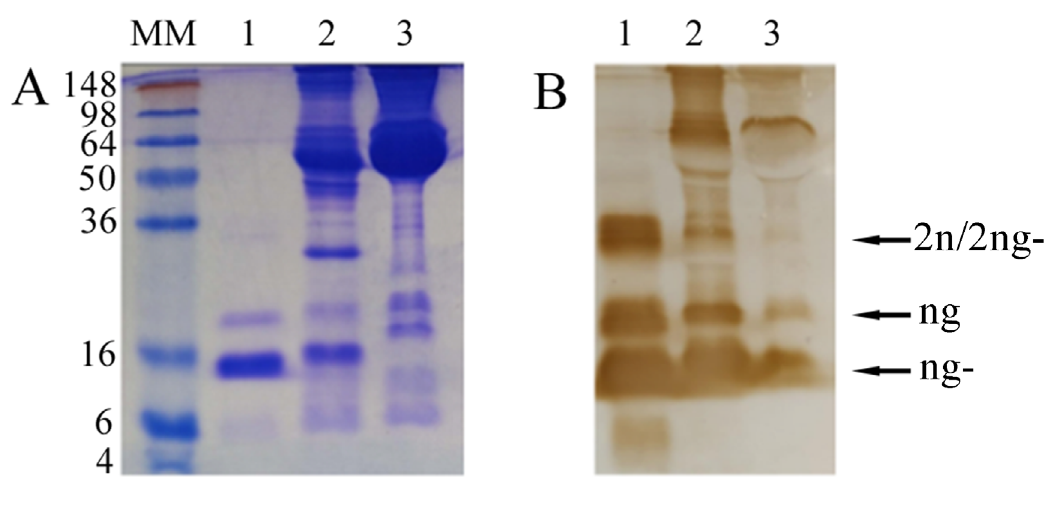
Figure 2. (A) SDS-PAGE 15% after staining with Coomassie Blue and (B) Western blotting revealed with anti-CNF IgG. Lanes: MM – molecular marker (in kDa) (SeeBlue Plus 2 Pre-stained Protein Standard, Invitrogen); 1 – CNF (20 µg); 2 – C. d. terrificus blood plasma (80 µg); 3 – B. constrictor blood plasma (80 µg). The arrows indicate non-glycosylated monomer (ng-), glycosylated monomer (ng) and possible dimers (2ng/2ng-).